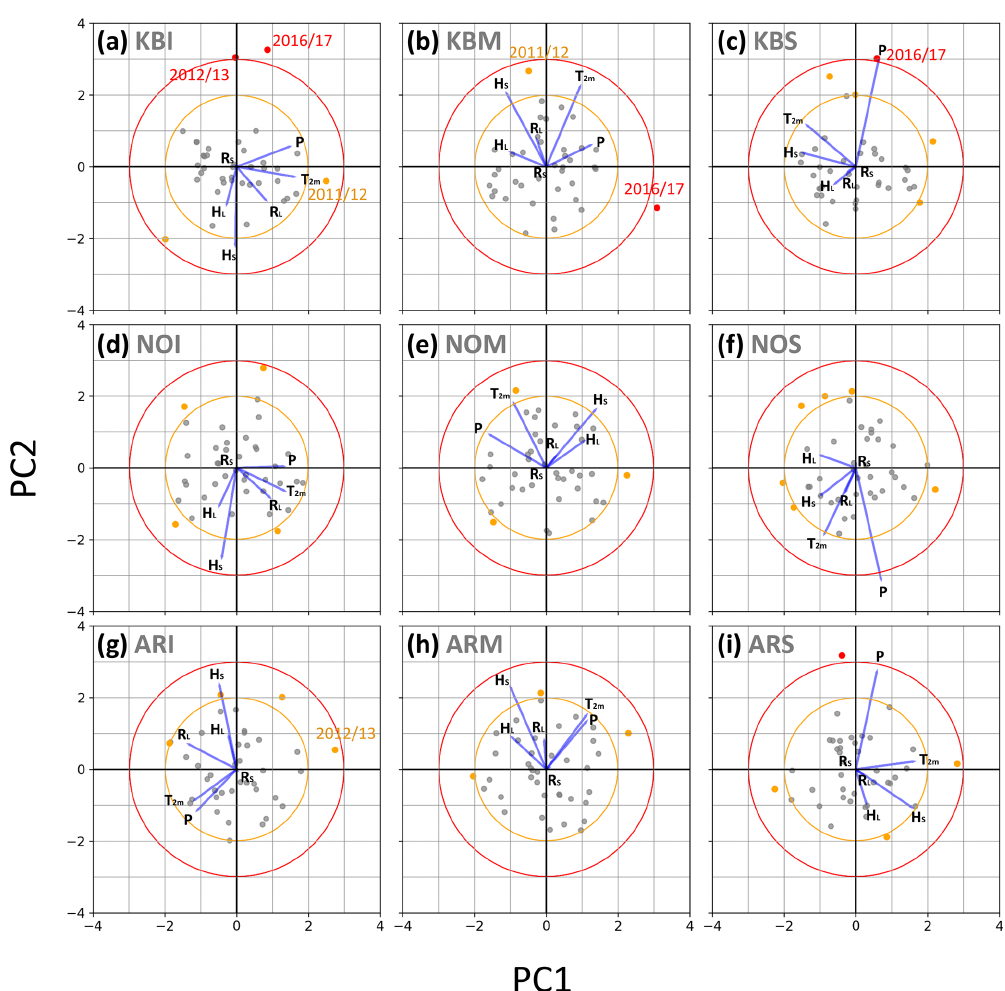
Figure 7. PCA biplot for all sub-regions in DJF with PC1 and PC2 along the x and y axis, respectively. Every season is represented by a grey dot, and red and orange dots show extreme and anomalous seasons, respectively. Blue lines represent the coefficients of the precursor variables. Red and orange circles represent d M = 3 and d M = 2, the thresholds used for extreme and anomalous seasons, respectively. Selected case study seasons are